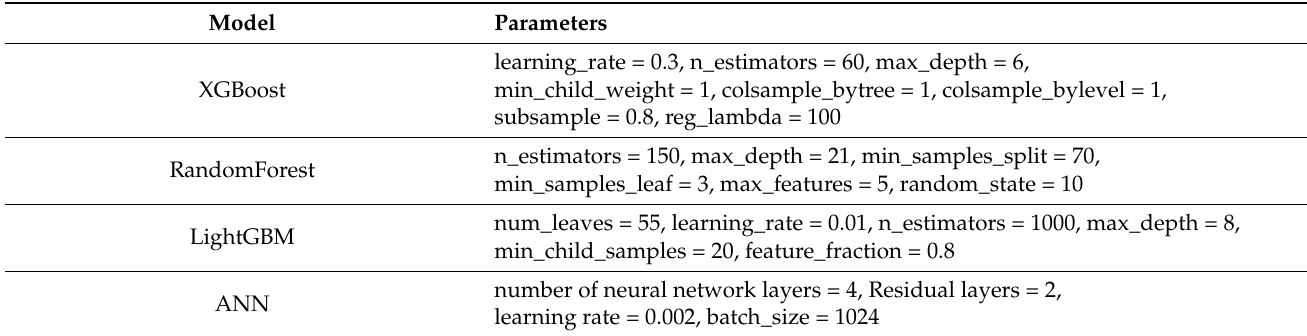
Table 2. Optimal combination of parameters of models.